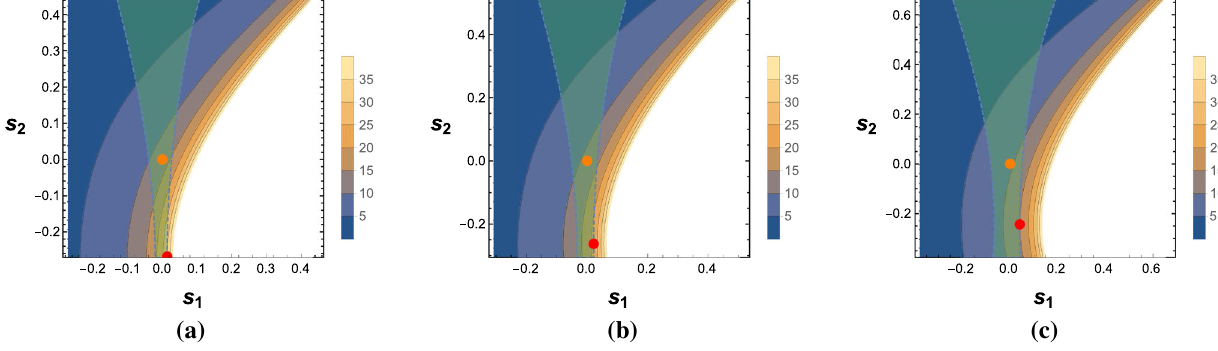
Fig. 3 The contour maps of E 3 in terms of s 1 and s 2 . The timelike condition for the particle 3 is satisfied in the green shaded region. The maximum value of E 3 for the spinning case is marked at the red point, and for the non-spinning case is marked at the orange point ( s 1 = 0 , s 2 = 0). a When n = 0, which corresponds to the Kerr case, for the spinning case, E 3 max ≈ 30 . 02 at ( s 1 = 0 . 01378 , s 2 = − 0 . 2679);